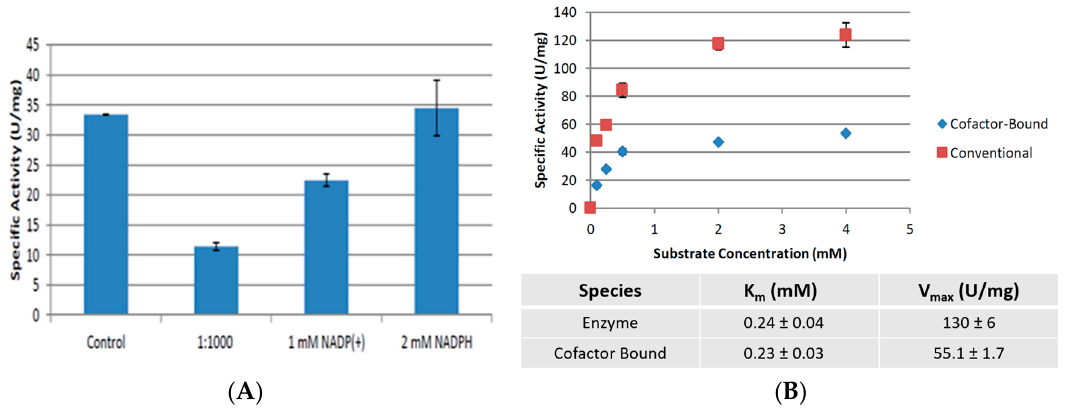
Figure 4. Effect of NADPH incubated CpCR on its activity. ( A ) Effect of incubation of different concentrations of NADPH on CpCR activity; ( B ) Kinetics of CpCR, NADPH bound vs. unbound.